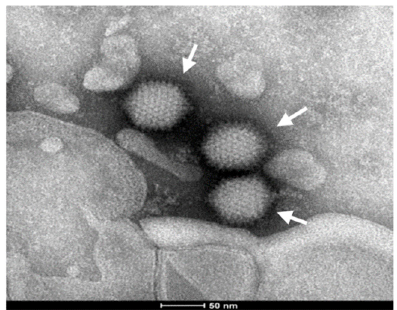
Figure 7. Electron micrograph visualization of pBRAdV14 derived viruses. Scale bar: 50 nm.